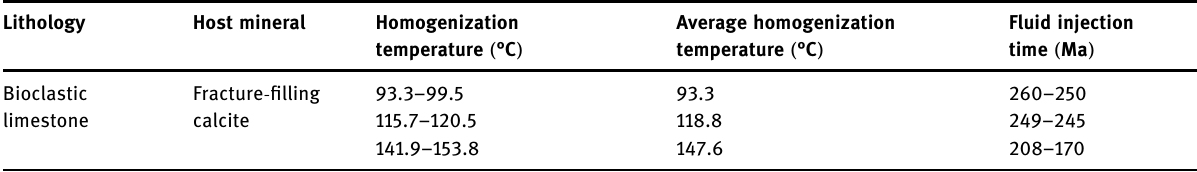
Table 1: Measures of inclusion homogenization temperature